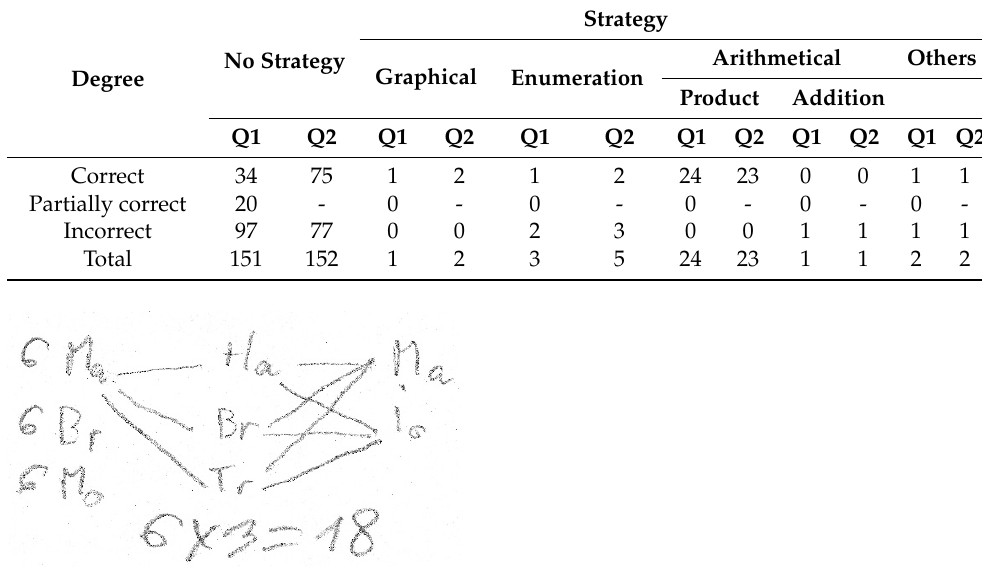
Figure 5. Correct answer of Q2. Combined strategy (others). Tree diagram product.